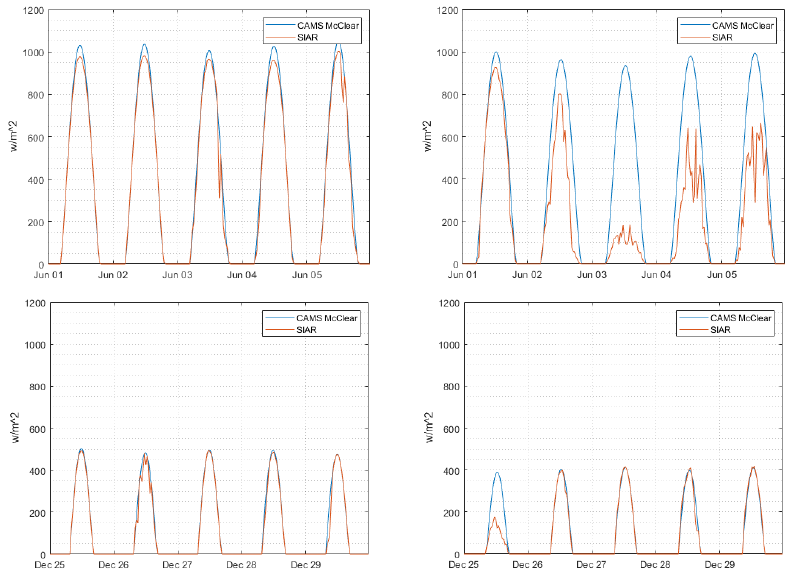
Figure 2. Presentation of GHI and GHIcs for 2 meteorological stations (V29 and C01) and 2 periods of 5 days in 2020 (winter and spring).